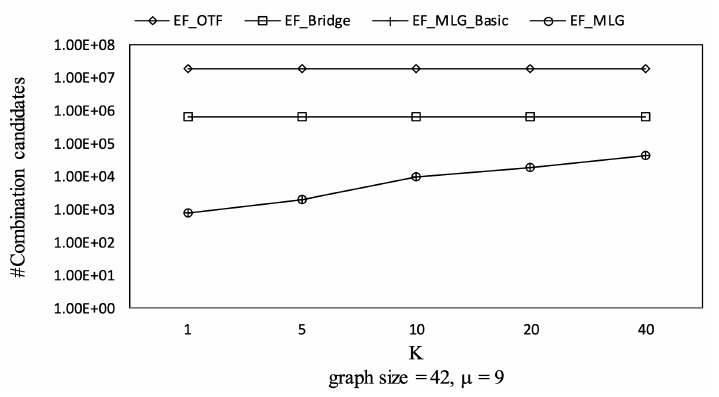
Figure 12. Combinations pruning on GraphGen vs. k with graphsize = 42 and µ =